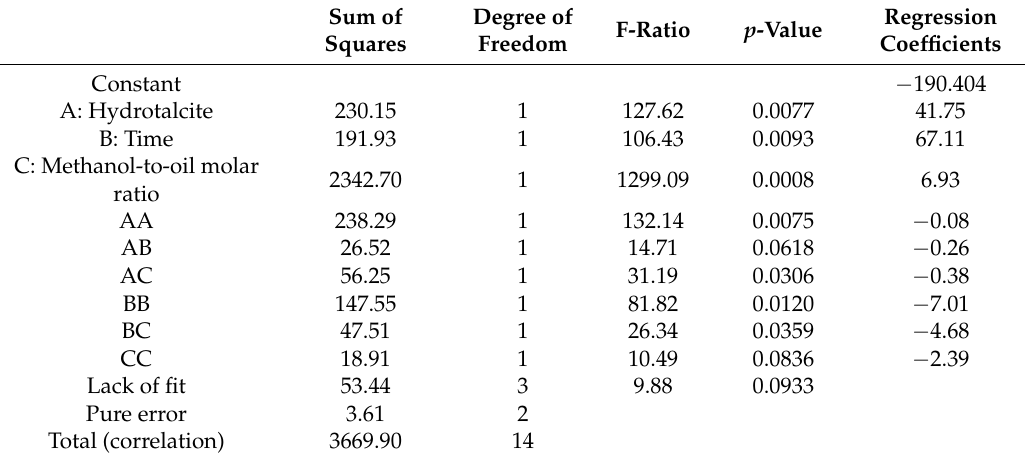
Table 4. Analysis of variance (ANOVA) test for response surface quadratic model and regression coefficients to describe the variability of the effects on FAME content (R-squared = 98.45%; R-squared adjusted for the degree of freedom = 95.65%; estimation standard error =